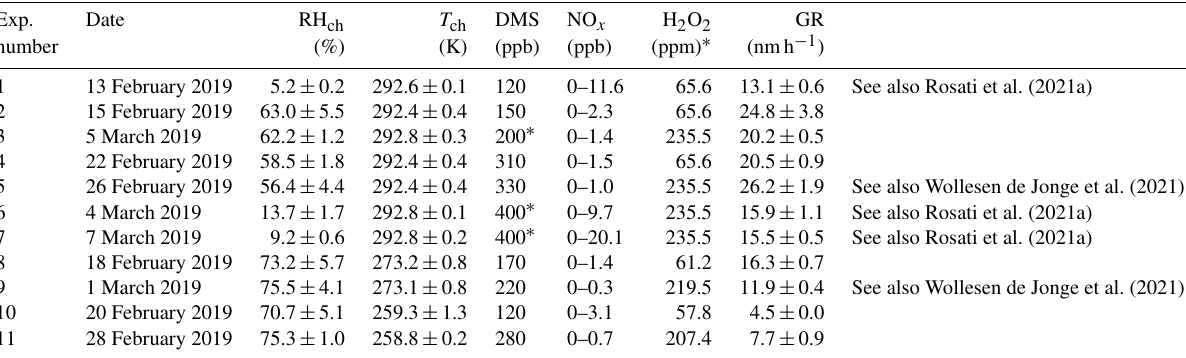
Table 1. Experimental conditions. T ch and RH ch denote the mean measured temperature and RH together with their standard deviations (1SD) in the chamber. The DMS concentrations indicate the measured concentrations after injection, except in Exp. 3, 6, and 7 – marked with an asterisk – where theoretical values are given based on the liquid injected into the chamber, as the PTR-ToF-MS was not available. Additionally, NO x concentration ranges, H 2 O 2 mixing ratios, and particle growth rates (GR) obtained for the size range 10–20nm are listed. Lower H 2 O 2 mixing ratios correspond to injections of 418µL, while higher ones correspond to injections of 1500µL. See also Rosati et al. (2021a) for additional information regarding Exp. 1, 6, and 7 and Wollesen de Jonge et al. (2021) for experiments 5 and 9. The last column specifies if any data of these experiments were previously